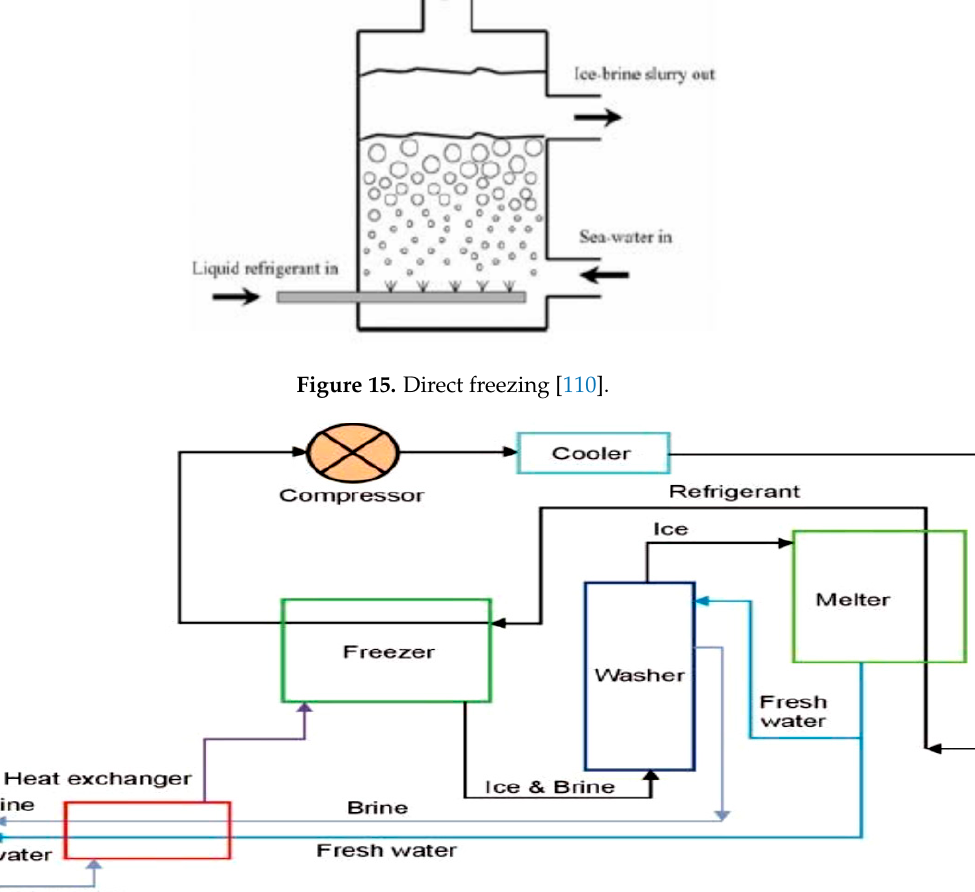
Figure 15. Direct freezing [110].